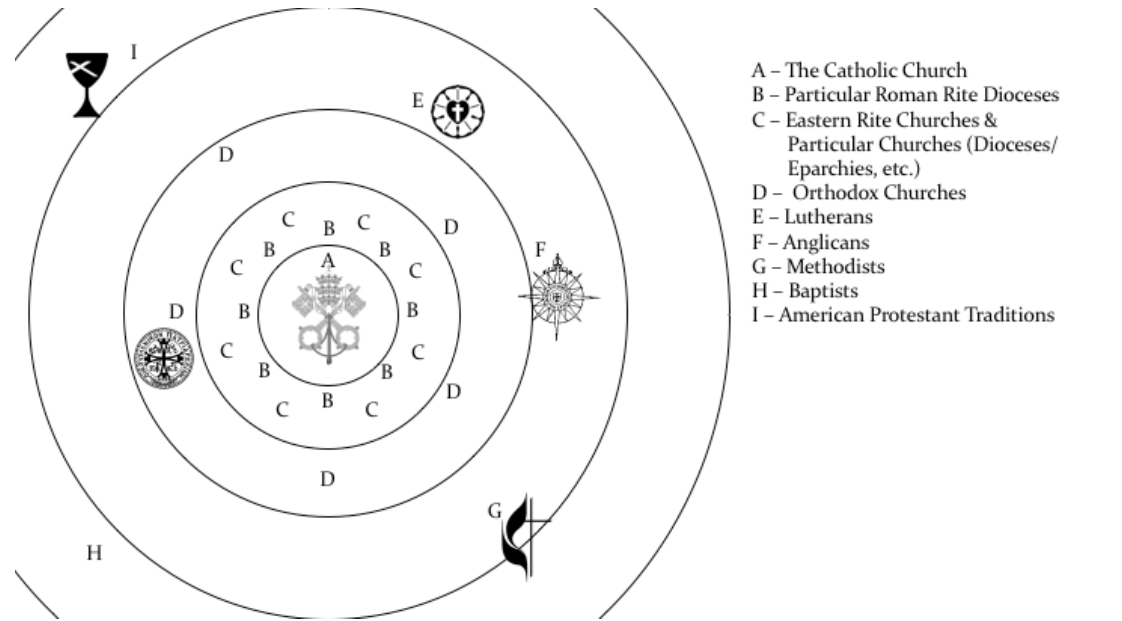
Fig.4: An Approximation of the Structure of the Category church Among Western